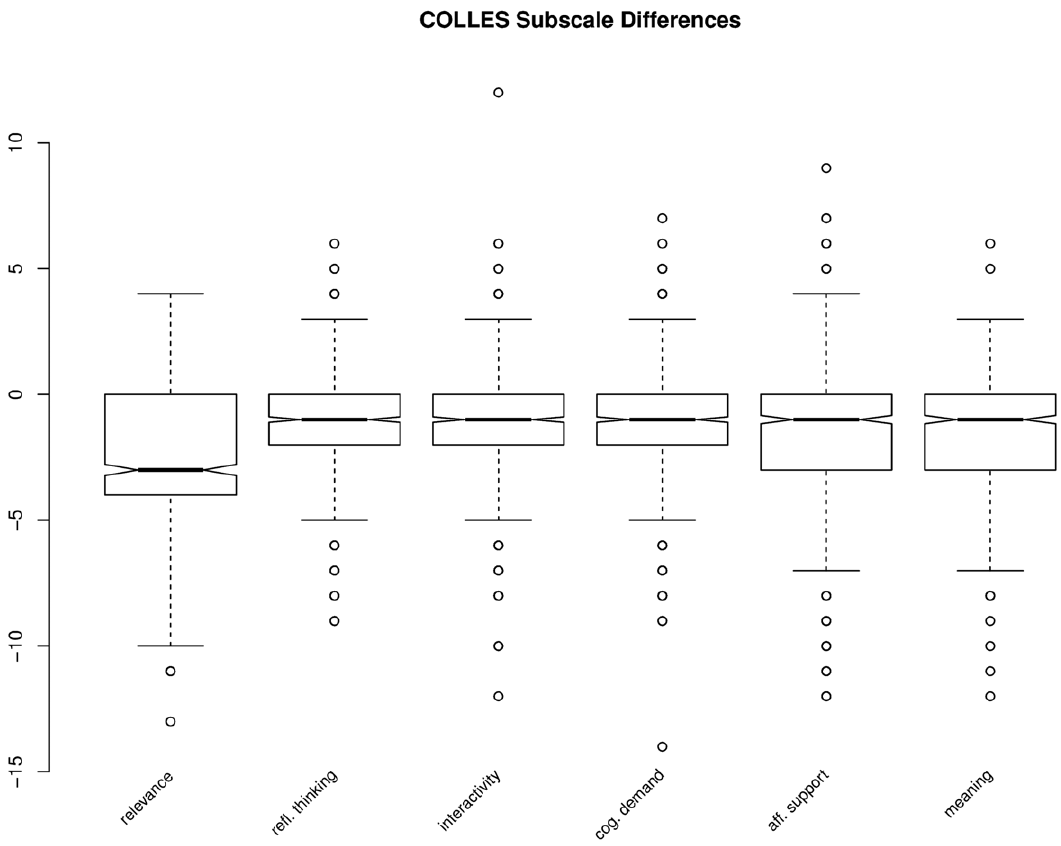
Figure 3. Differences in COLLES subscales (4 consecutive years, N=804) (www.wessa.net/rwasp_PRcolles.wasp).